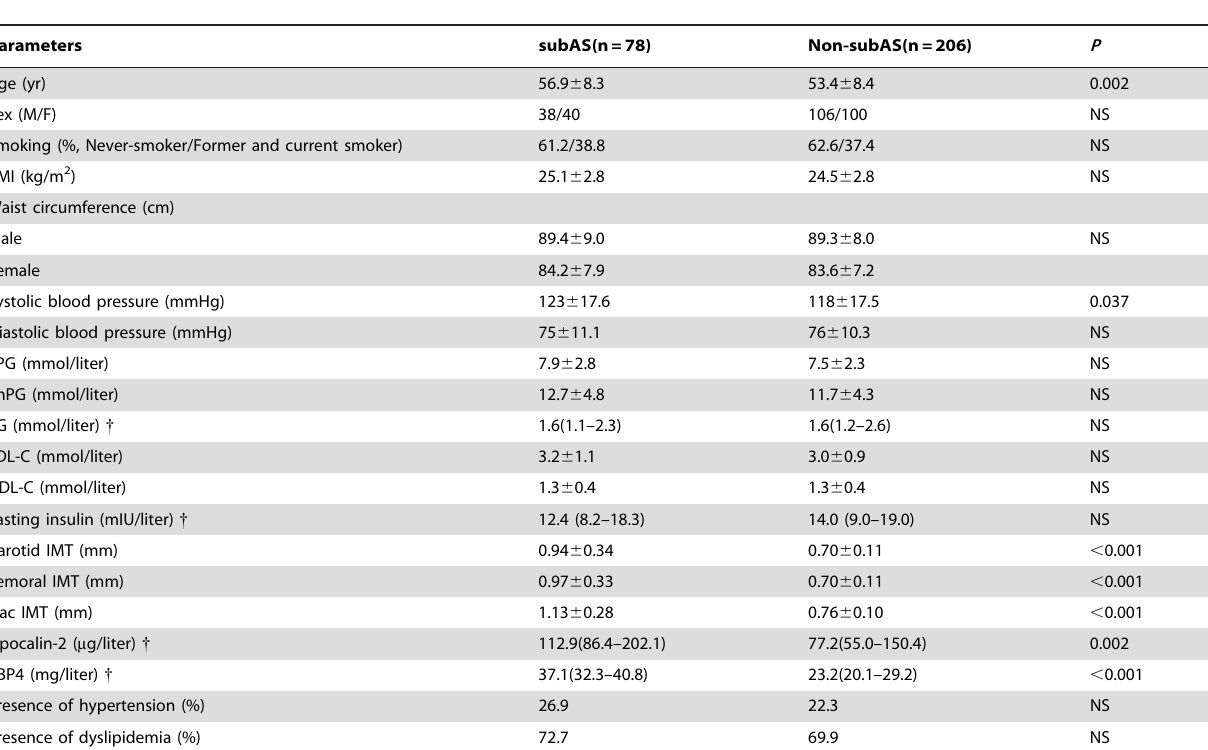
Table 1. Anthropometric and biochemical characteristics of type 2 diabetic subjects subdivided into subAS and non-subAS